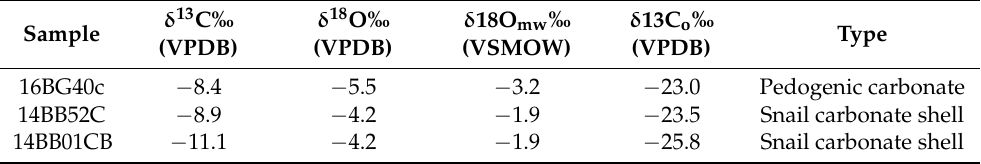
Table 2. δ 13 C and δ 18 O values for modern carbonates sampled in the Bagua basin.